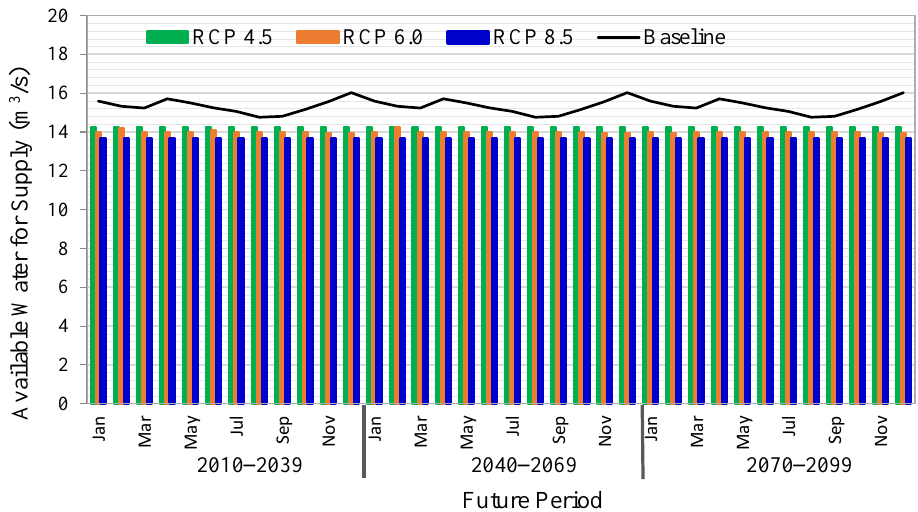
Figure 10. Projected ensemble mean monthly supply and future changes under RCPs (RCPs 4.5, 6.0,